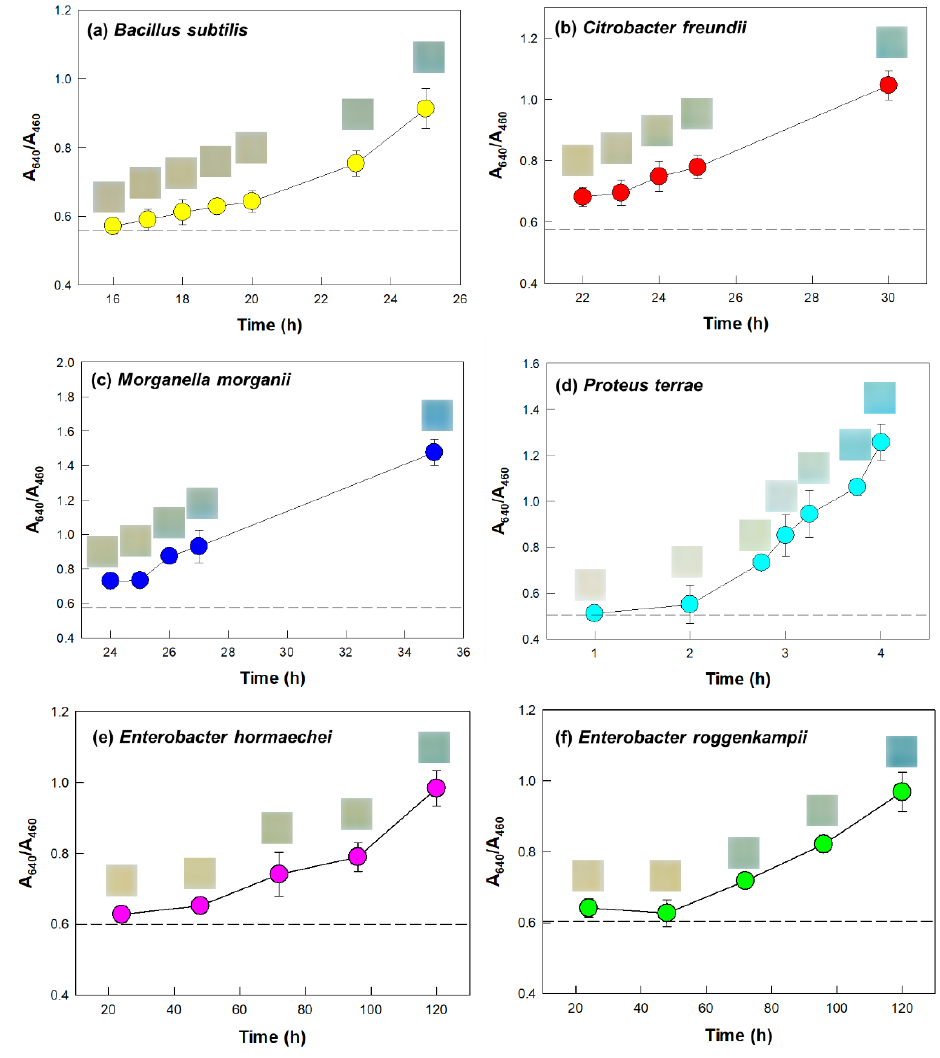
Figure 4. ( a – f ) Colorimetric detection of ureolytic bacteria using the designed film sensor. The A 640 /A 460 values of sensors exposed to indicated bacteria plotted against incubation duration. Insets show photographs of the sensors. The dashed lines each indicate the A 640 /A 460 value of the sensor in the absence of inoculum (negative control). Symbols and error bars represent the mean and standard deviations of biological triplicates.